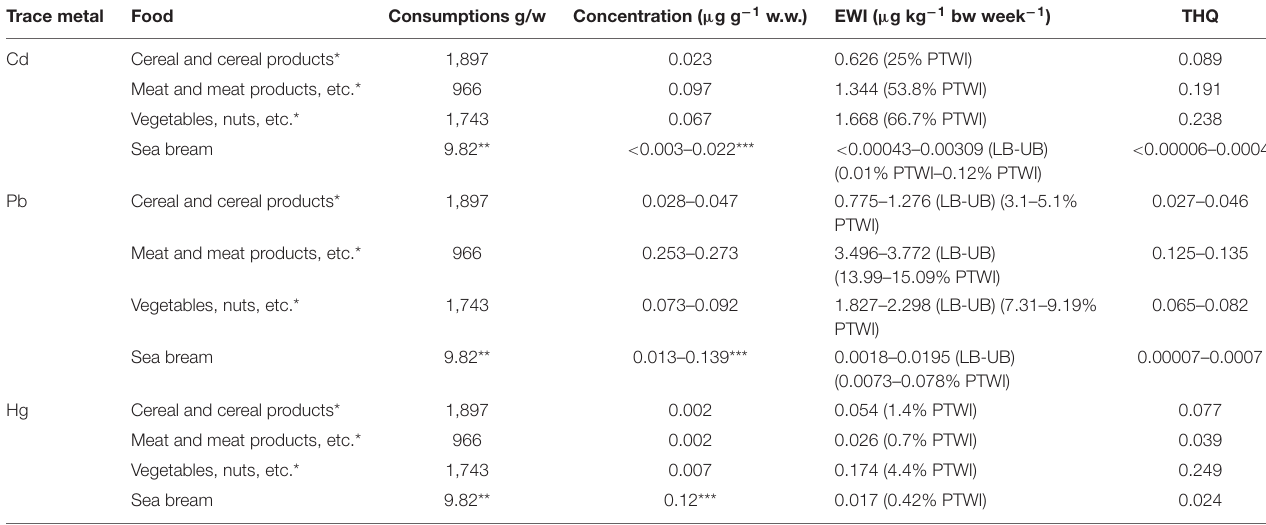
TABLE 4 | Estimated weekly intakes (EWIs and EWIs compared to PTWIs) and target hazard quotients (THQs) for trace metals (Cd, Pb, and Hg) by consumptions and concentrations for different foods. Trace metal